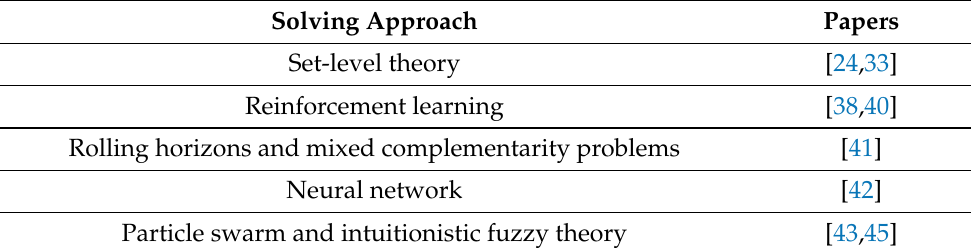
Table 1. Approaches to solve pursuit–evasion games and papers which use